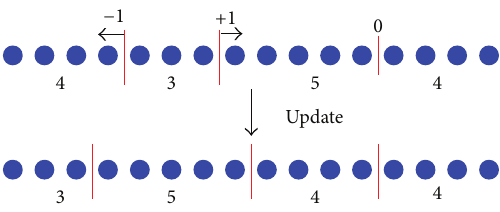
Figure 1: Geometry of the subarrayed antenna array. Figure 2: An example of ternary adjusting method with 𝑁 = 16 and 𝑄 = 4 , the integer vector is updated from [4,3,5,4] to [3,5,4,4] with m = [−1,1, 0]